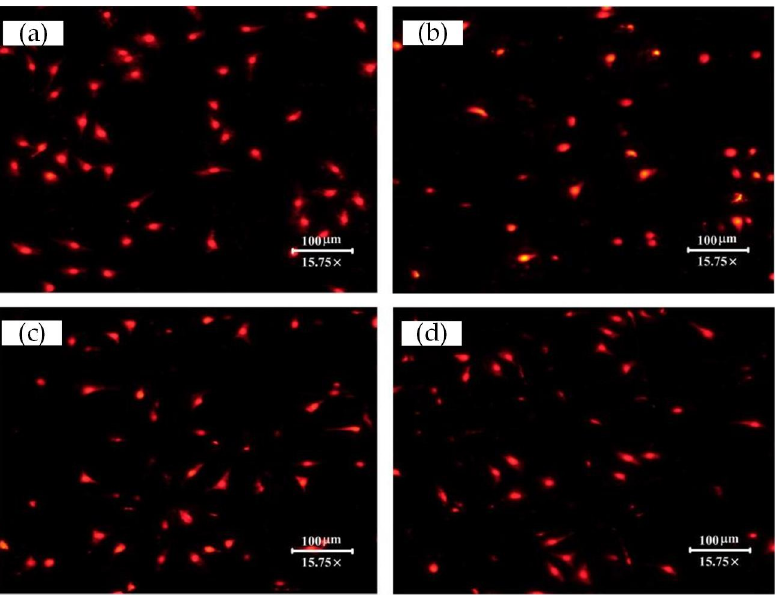
Figure 8. Stereo fluorescence microscope pictures taken for MC3T3-E1 cells adherent on the different surfaces after culturing for 6 h presented the variation in cell density and cell numbers: ( a ) Smooth; ( b )Texture 1; ( c )Texture 2; and ( d )Texture 3.